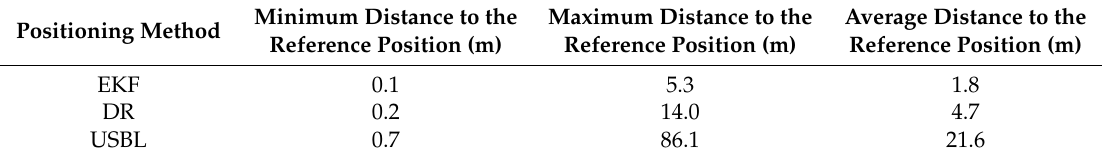
Table 3. Parameters of statistical positioning errors by EKF, DR and USBL system (single passage). Positioning Method